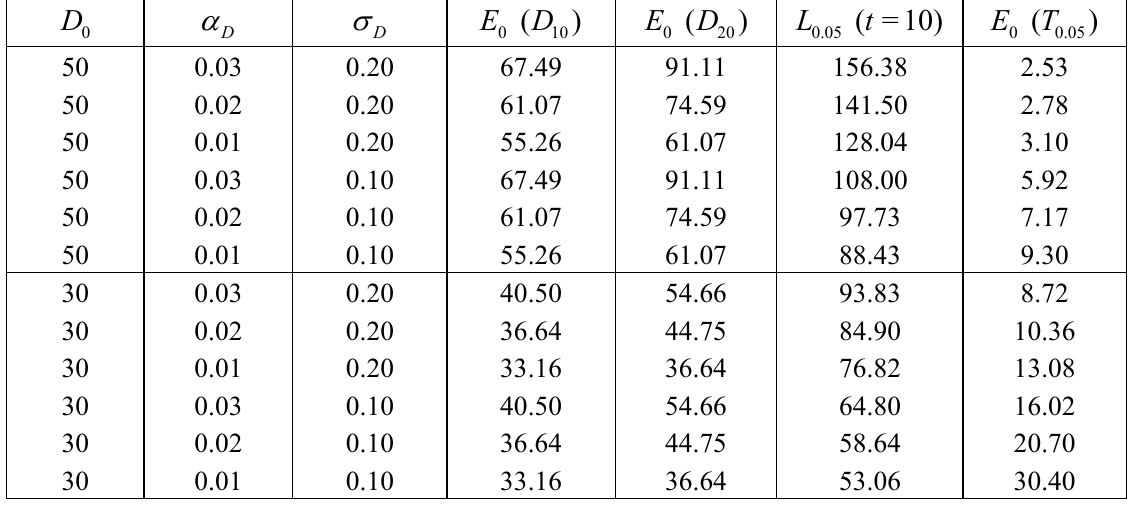
Table 14. Expected load, 5%-upper bound, and passage time